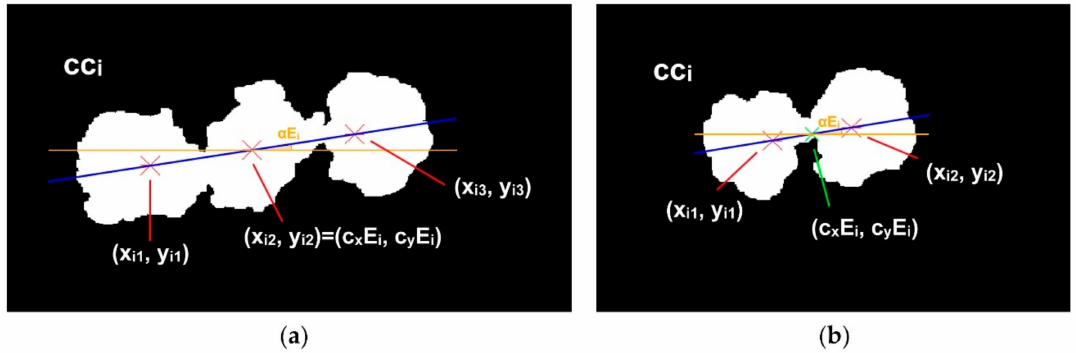
Figure 12. Illustration of the process to estimate a representative location for aggregated trees, formulated in Equations (17)–(19). Examples for odd ( a ) and even ( b ) number of aggregated trees are given.